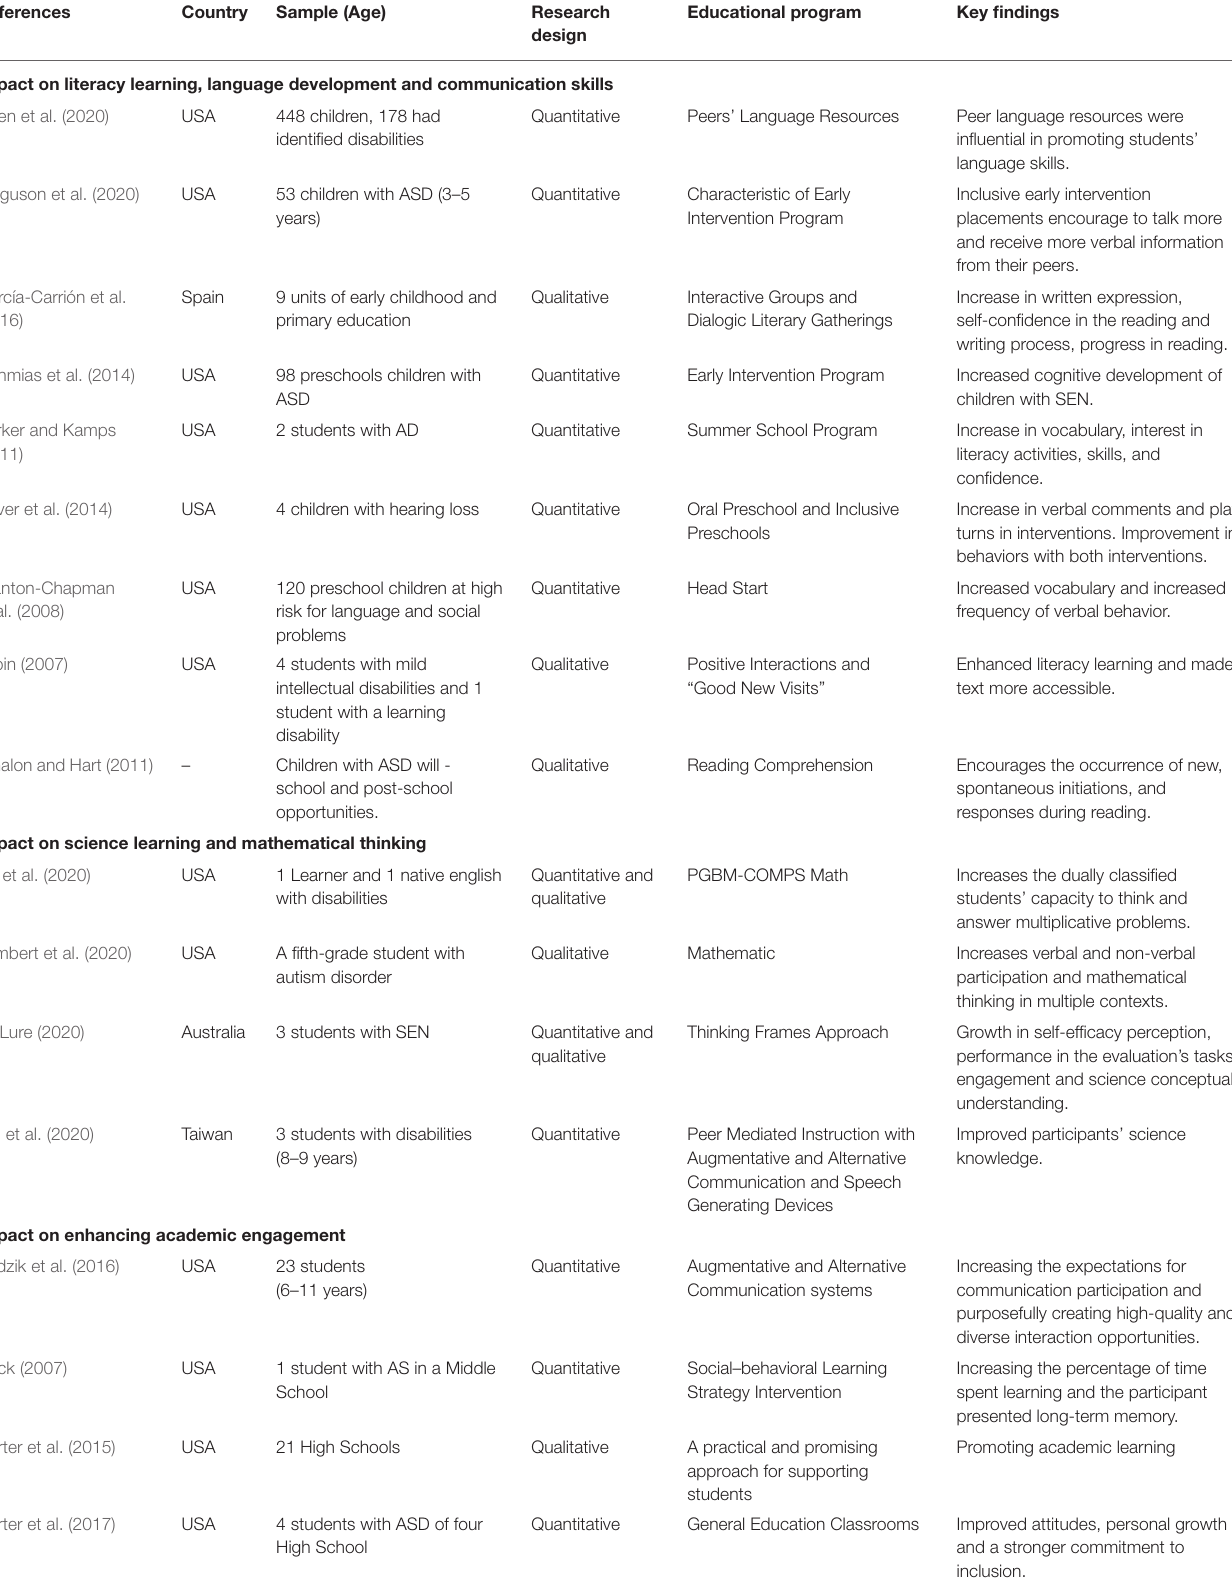
TABLE 1 | Summary of articles from the literature